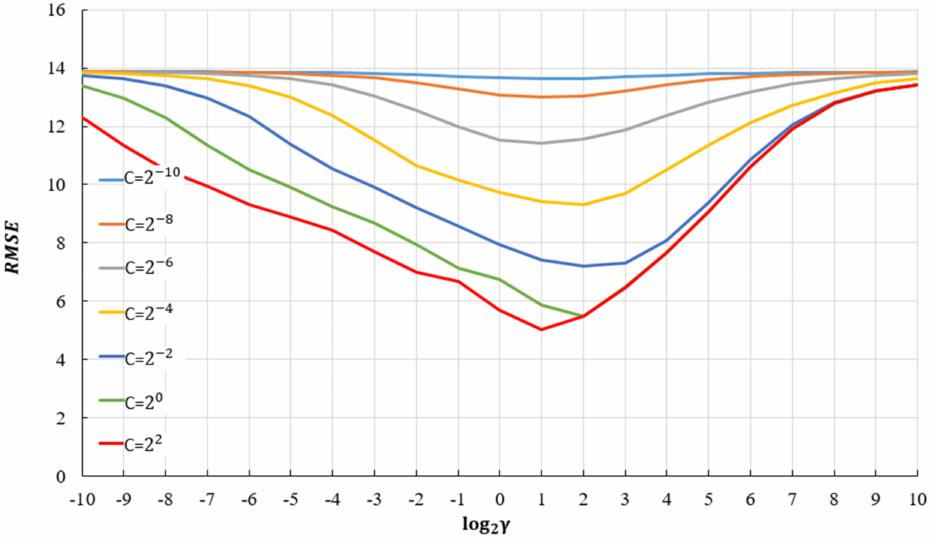
Figure 16. RMSE vs. hyperparameters C and γ for ε = 2 − 6 using SVR with RBF kernel in rough grid search.